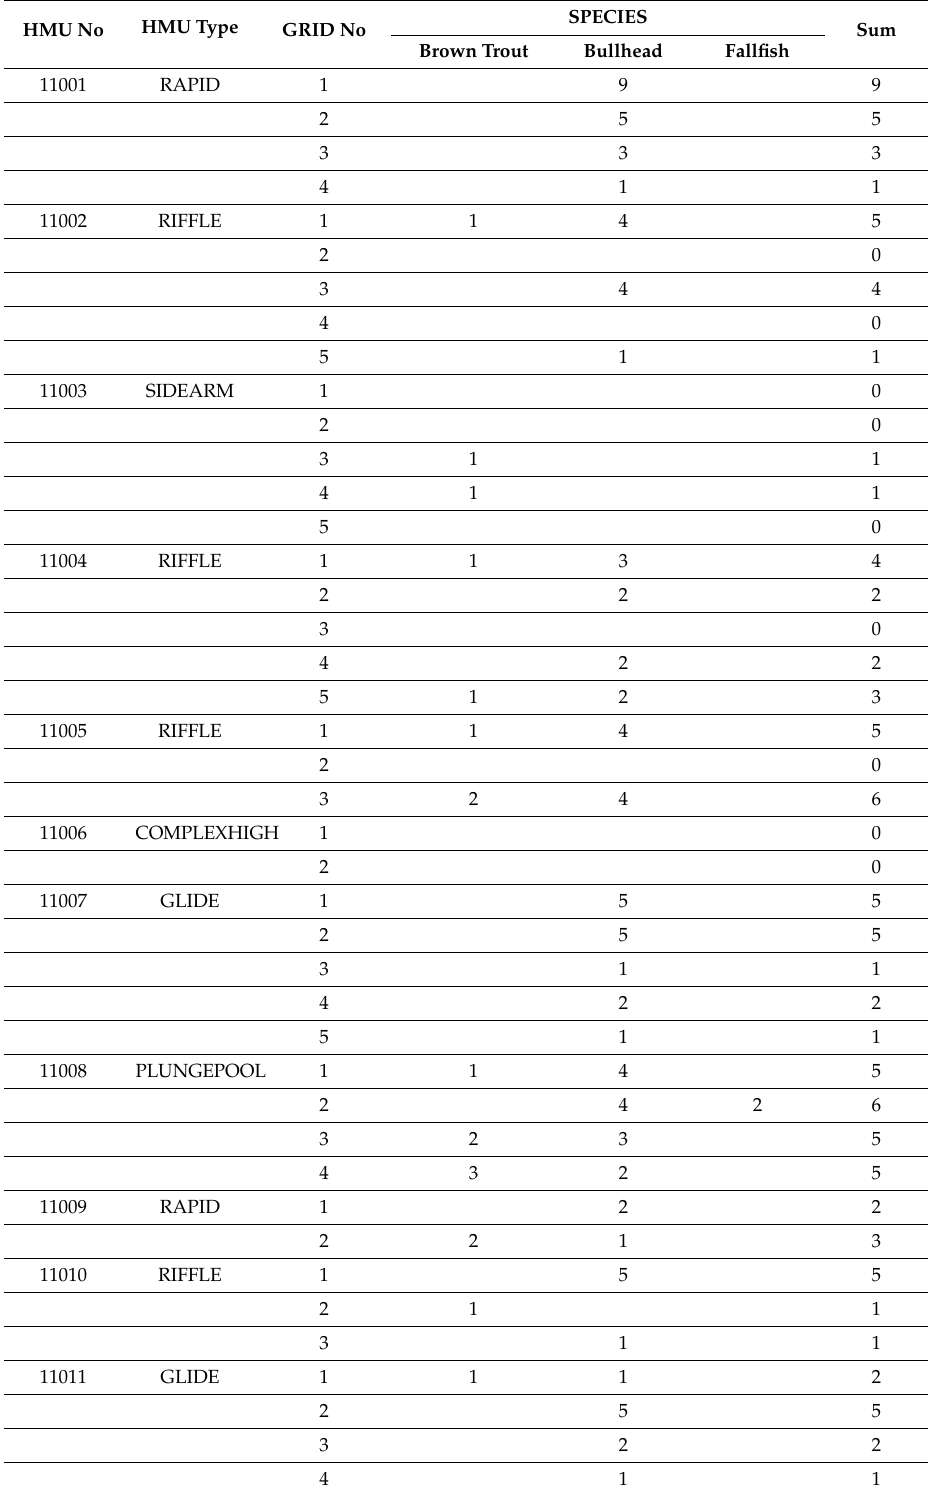
Table A1. List of fished HMU with grid number and number of fish caught: brown trout ( Salmo trutta fario ), bullhead ( Cottus gobio ), and fallfish ( Leuciscus sou ffi a ). Data from both sites were combined